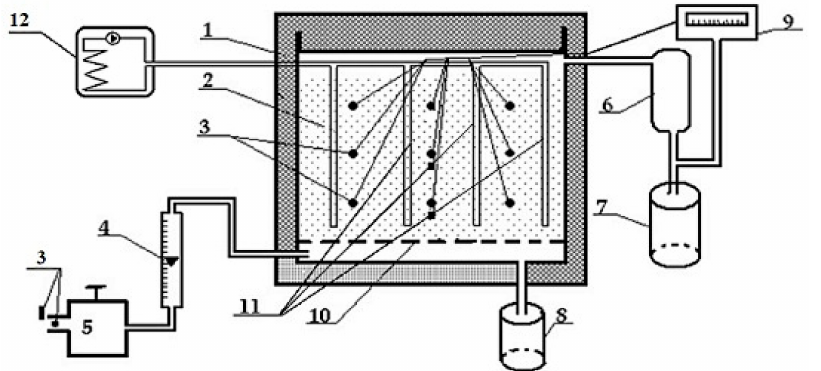
Figure 1. Schematic diagram of the system for laboratory composting with heat collection